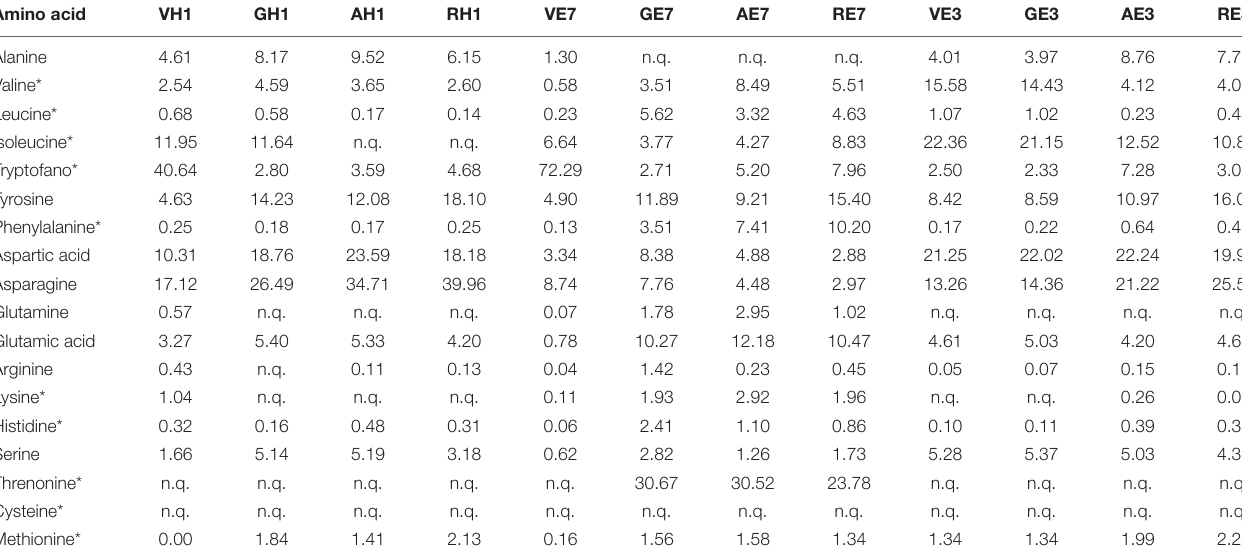
TABLE 5 | Amino acids identified in A. unedo fruit extracts by LC-MS/MS analysis (expressed as percentage, %). Amino